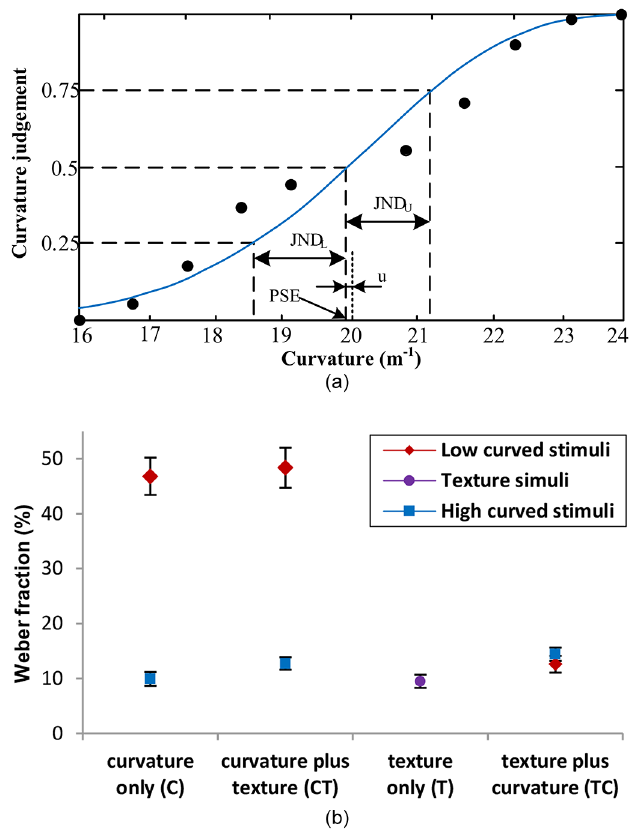
Fig. 6. (a) An exemplary fi gure on an individual psychometric fi t. (b) Results of Exp.1. Weber fractions for the discrimination threshold of tactile cues under four conditions, where the diamond sign denotes using low curved stimuli, the cube sign denotes using high curved stimuli, and the circle sign denotes using texture stimuli